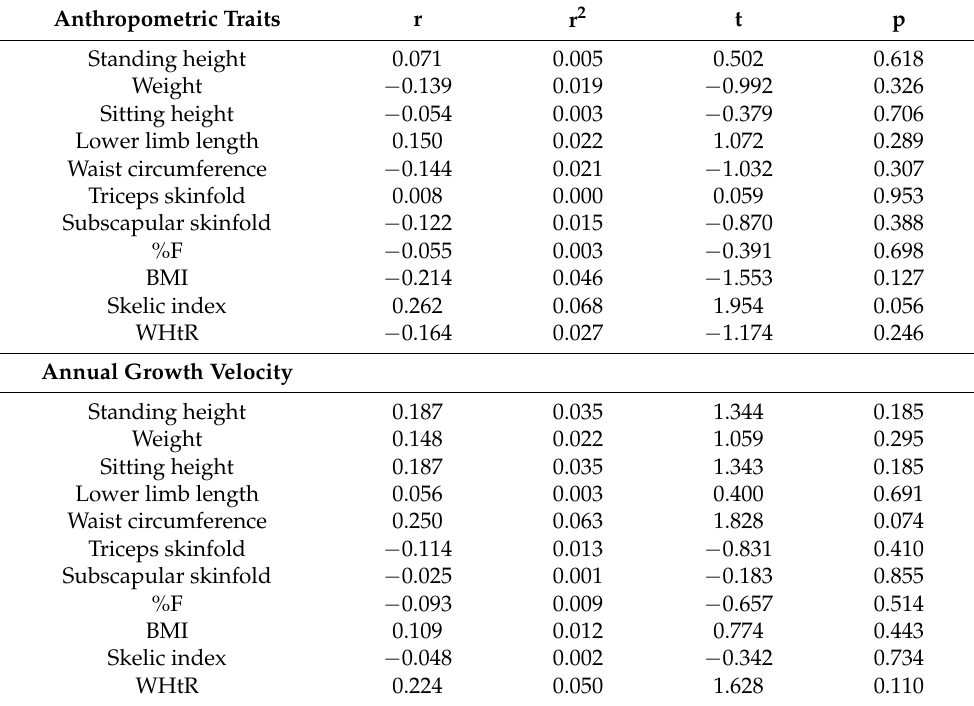
Table 3. Pearson correlation between anthropometric variables and categories of AAM (<11 years; 11 years ≤ age at menarche ≤ 12 years; >12 years) (N = 54). Anthropometric Traits r r